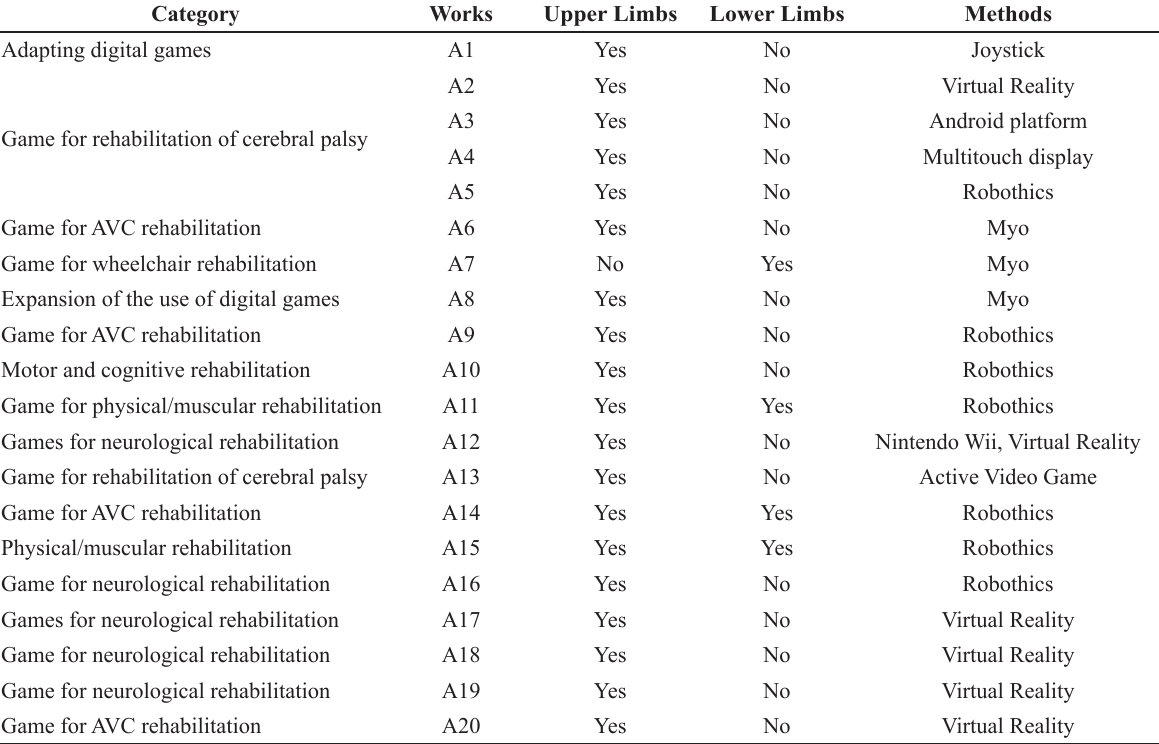
Comparation between selected